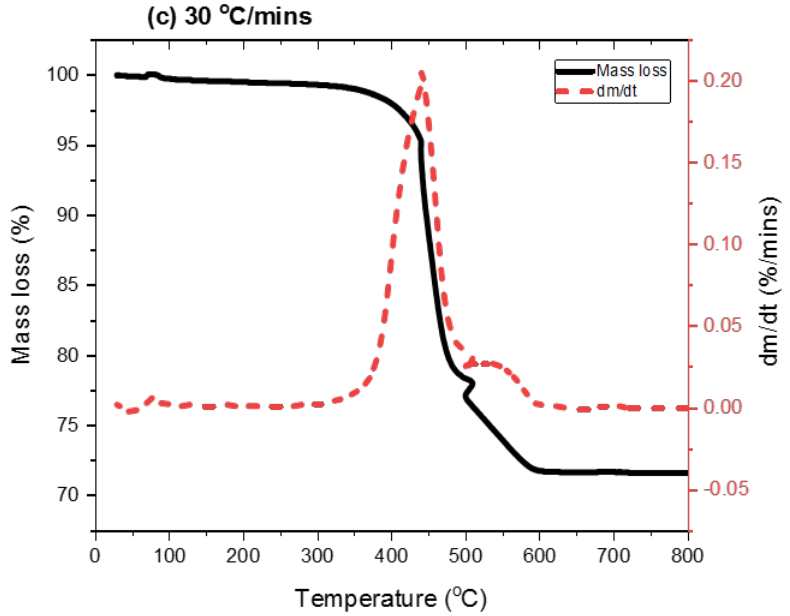
Figure 4. TGA and derivative thermogravimetric (DTG) thermogram of PET MPs at different heating rates. Table 2. The onset, end-set and peak values of the PET MPs’ thermal degradation at different heating rates.